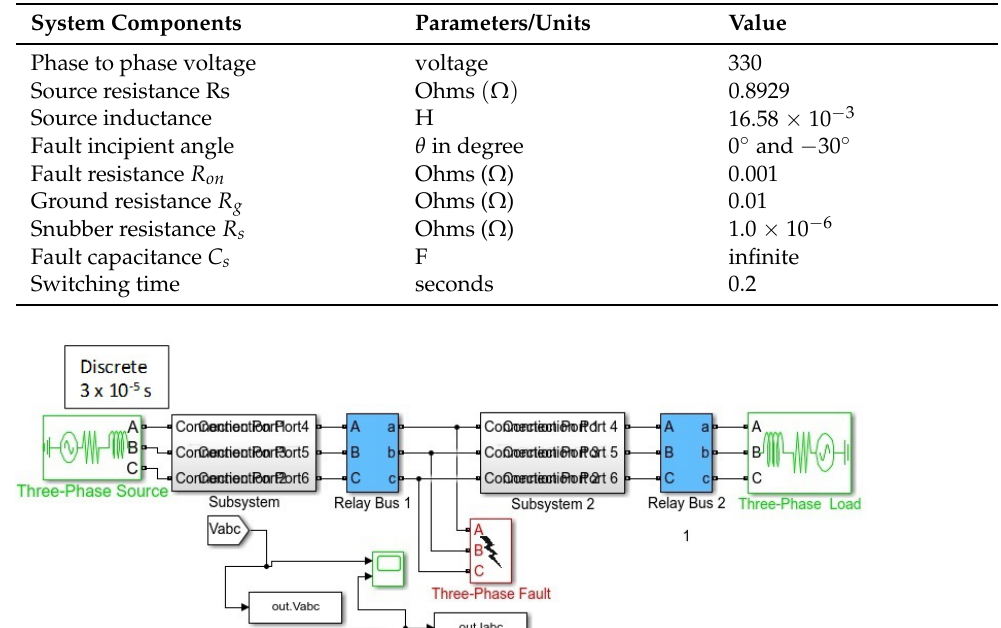
Table 2. Fault parameters of the proposed model.